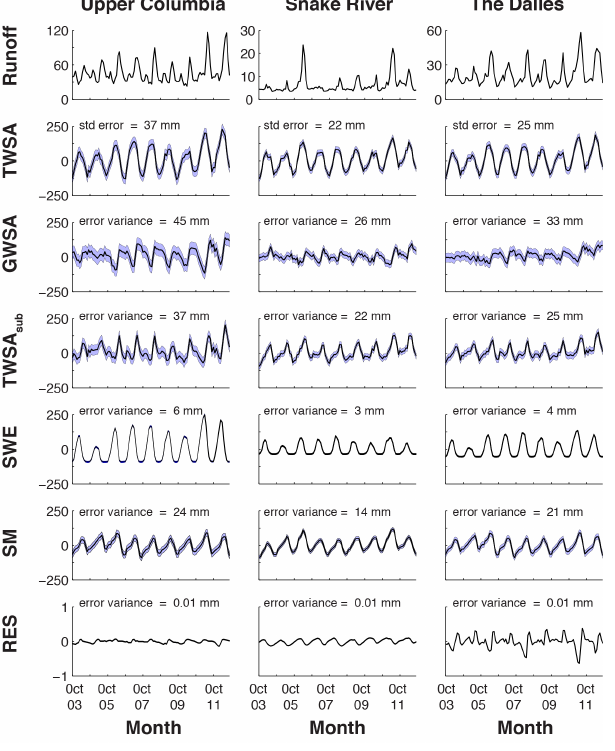
Figure 2. Monthly storage anomalies for Runoff, TWSA, and the subcomponents of terrestrial water for the three watersheds. Stan- dard errors and error variance for hydrological component are noted in each sub-figure and represented by the blue shading. All units on the vertical axes are on the same scale and inmm. Note the different vertical scales for Runoff and RES. Horizontal axes are in months and on the same